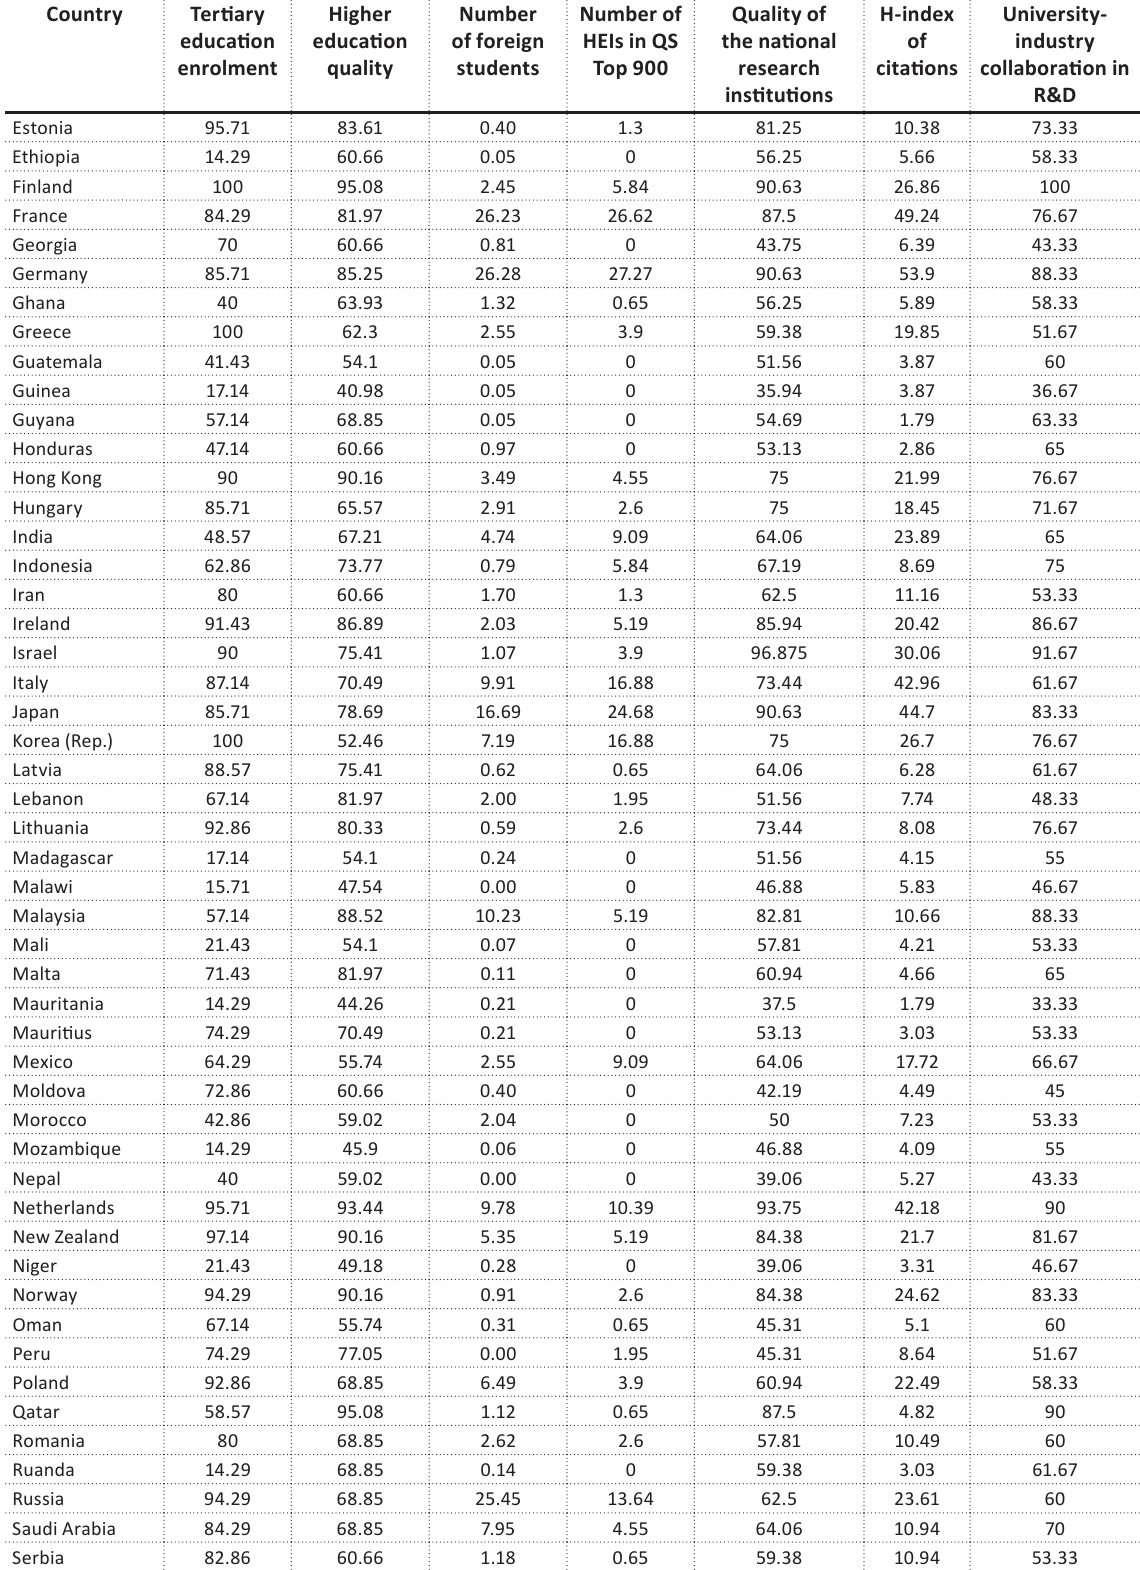
Table A1 (cont.). Data used for calculations of Higher Education Systems’ Ranking and cluster analysis